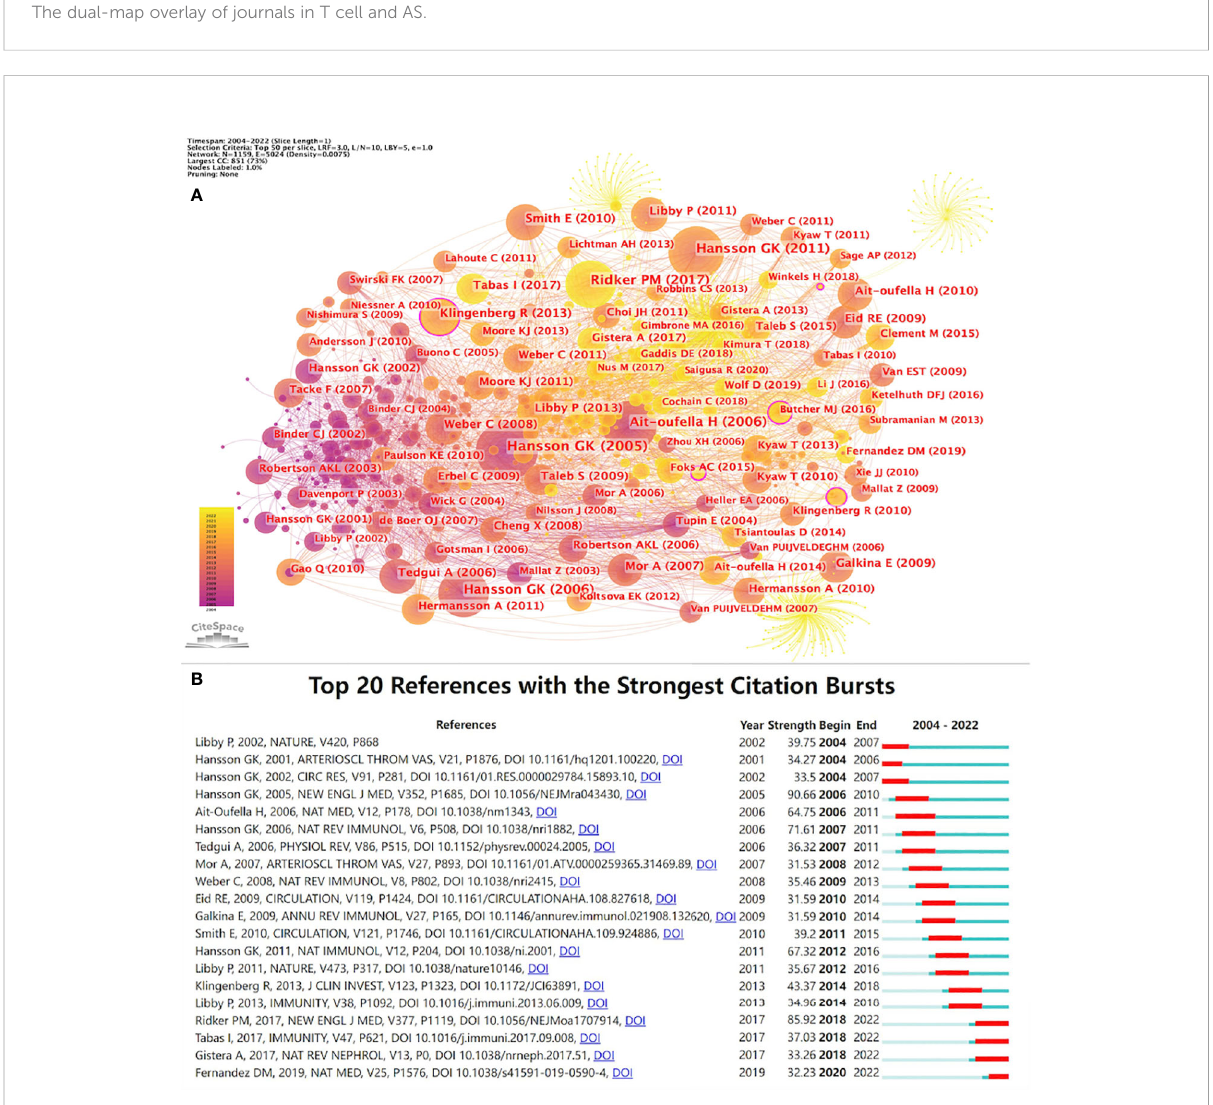
FIGURE 6 (A) References co-citation network in T cell and AS. (B) Top 20 references with the strongest citation bursts in T cell and